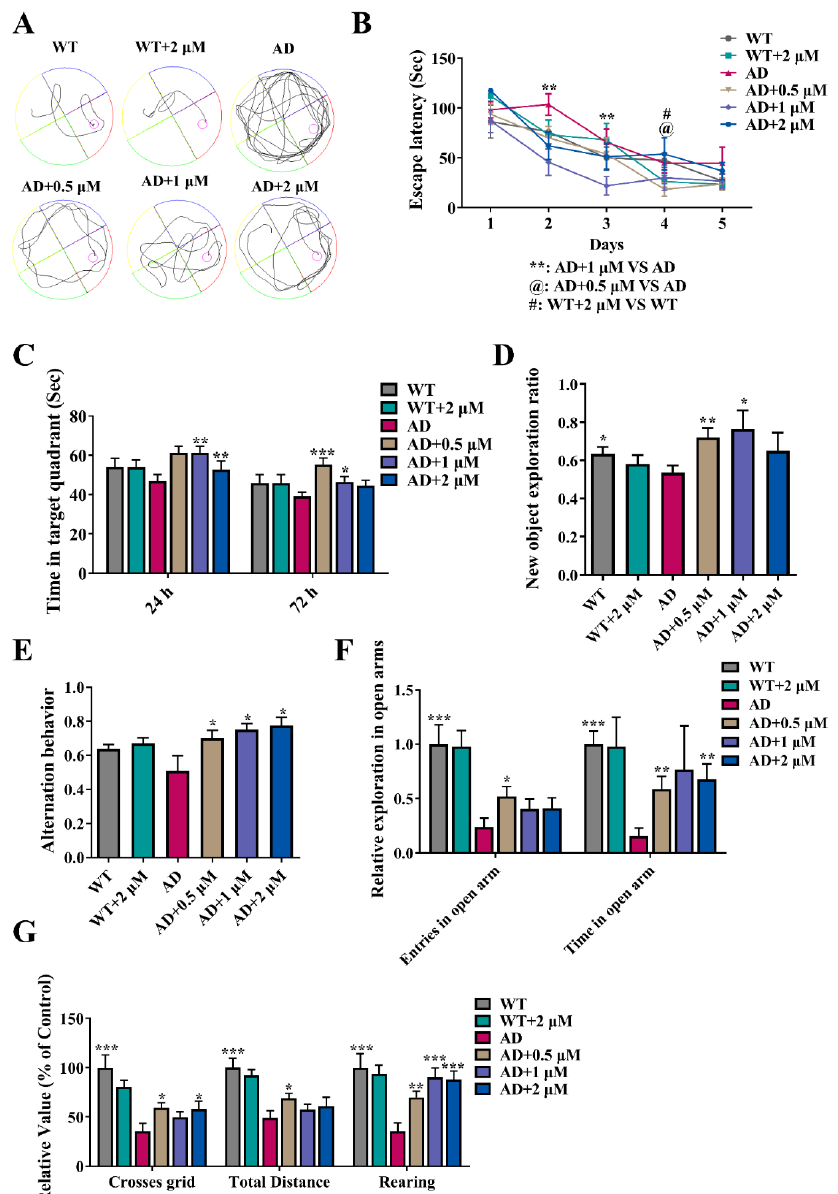
Figure 2. Ebselen administration improved cognitive deficits of 9-month-old AD mice: ( A – C ) Morris water maze involving the representative swimming trajectory for mice on Day 5 in a learning trial